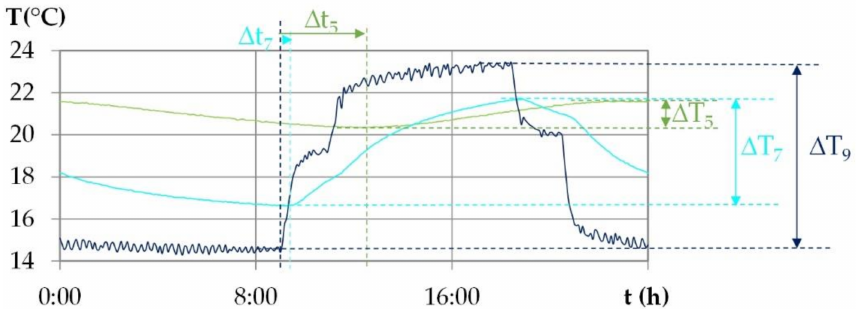
Figure 8. Example of identification of the temperature shift phase ∆ t between the surface (9) and given points (5 and 7) and of the temperature amplitude at the surface and at given